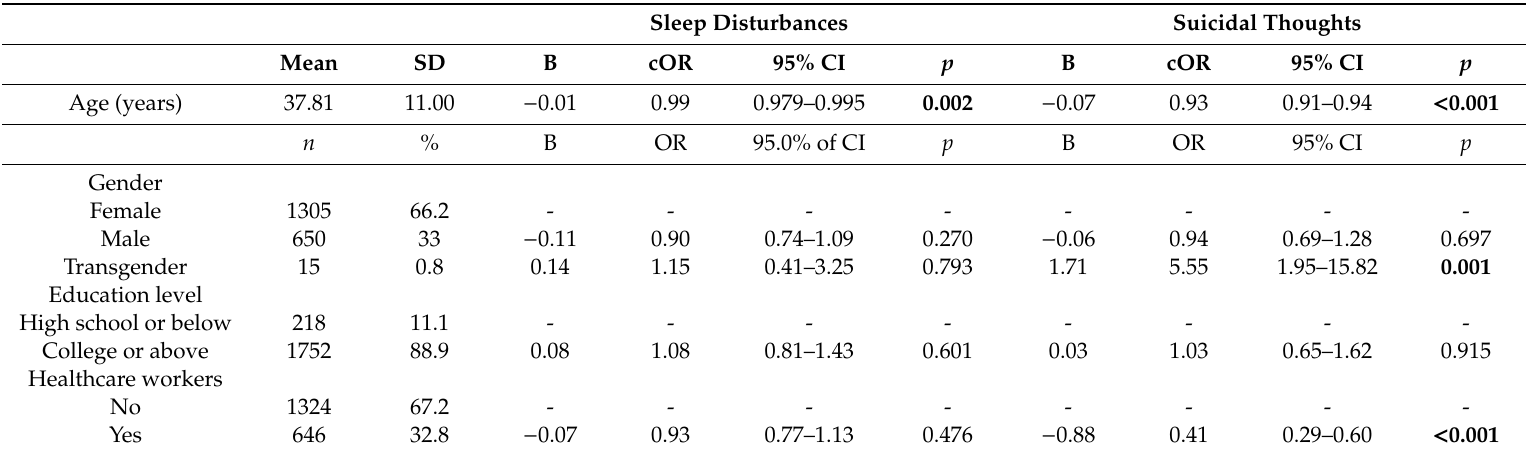
Table 1. Associations of demographic factors with sleep disturbance and suicidal thoughts examined by univariate logistic regression ( n = 1970). Sleep